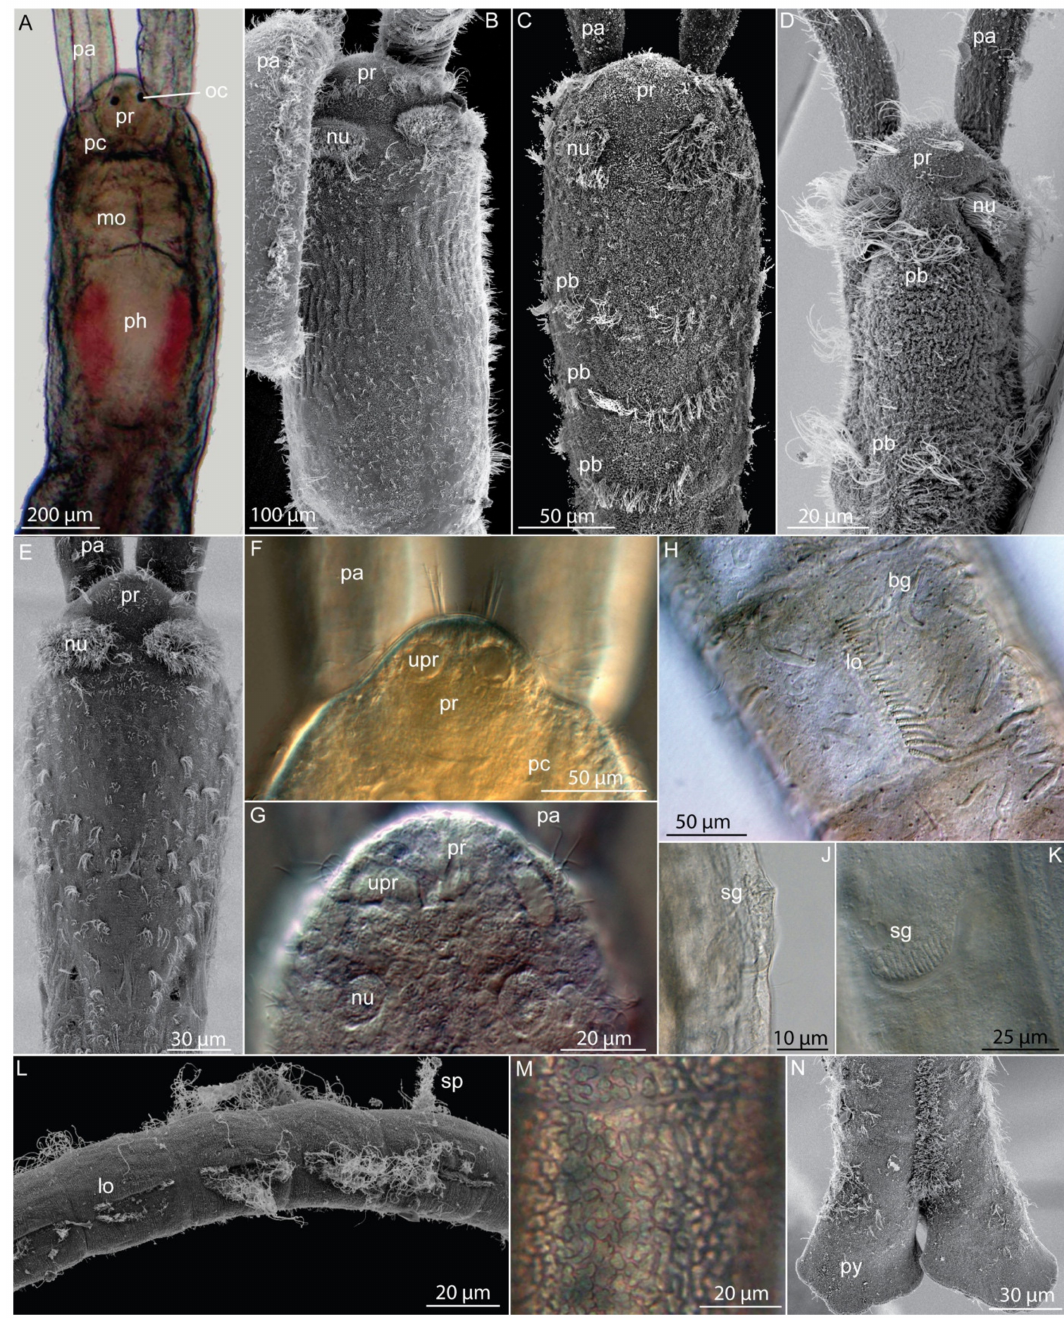
Figure 11. Morphology of Protodrilidae. ( A , F , N ) Lindrilus sp. (La Palma, Canary Islands). ( B ) Megadrilus schneideri (Capo Caccia, Sardegna, Italy). ( C , M ) Claudrilus cf. hipoleucus (Tenerife, Canary Islands). ( D ) Meiodrilus sp. (Phuket, Thailand). ( E ) Protodrilus smithsoni (Bocas del Toro, Panama). ( G ) Claudrilus hypoleucus (La Maddalena, Sardegna, Italy). ( H , J , K ) Meiodrilus adhaerens (Svinbaden, Helsingør, Denmark). ( L ) Claudrilus ovarium (Parana, Brasil). ( A ) Light micrographs of the anterior region. ( B – E ) Scanning electron micrographs of the anterior region. ( F – G ) Light micrographs of the prostomium showing different types of photoreceptors. ( H – K ) Light micrographs of the trunk segments showing adhesive and bacillary glands. ( L ) Scanning electron micrograph of the lateral organs and sperm cells. ( M ) Light micrograph of a trunk segment showing the epidermal glands. ( N ) Scanning electron micrograph of the pygidium. Abbreviations: bg, bacillary gland; lo, lateral organs; nu, nuchal organ; oc, ocelli; pa, palps; pb, prostomial ciliary band; pc, palp canal; ph, pharynx; pr, prostomium; mo, mouth; py, pygidium; sg, segmental adhesive glands; sp, sperm cells; upr, unpigmented prostomial receptor. All images reproduced with permission from